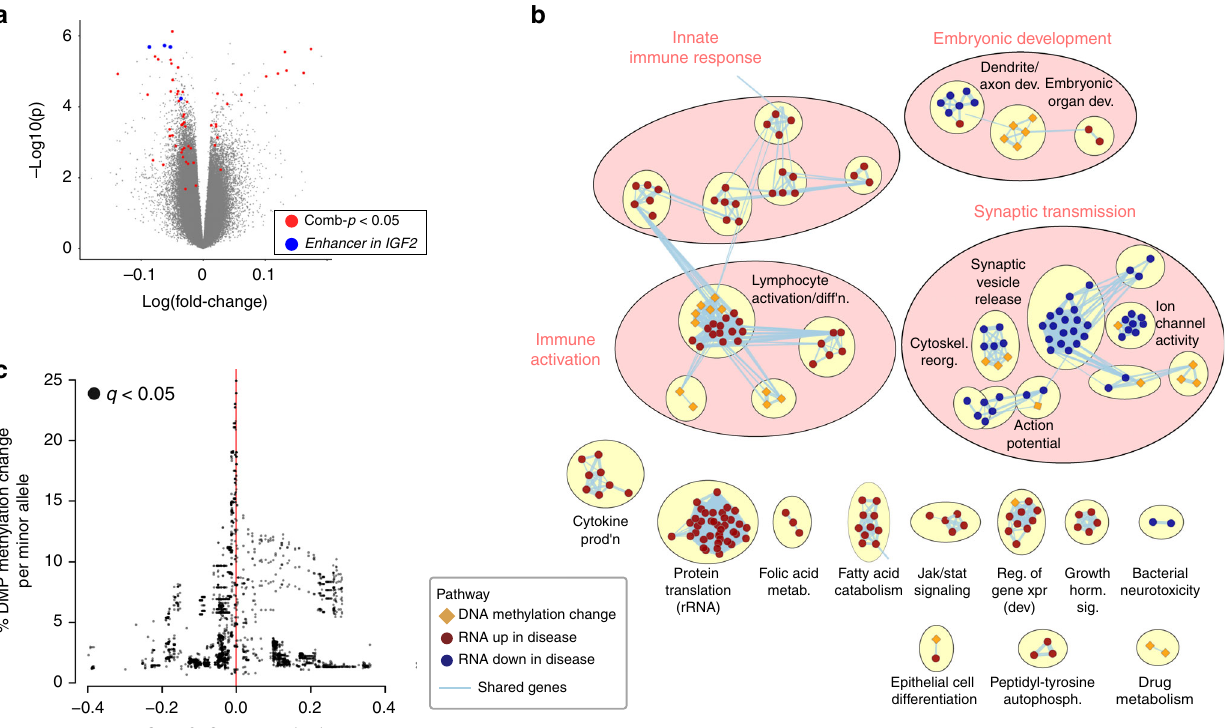
Fig. 1 Epigenetic and transcriptomic alterations in frontal cortex neurons in major psychosis. a Volcano plot showing DNA methylation differences in neurons of major psychosis patients ( n = 55 individuals) relative to controls ( n = 27 individuals). Disease-speci fi c DNA methylation changes were identi fi ed, after controlling for sex, age, post-mortem interval, and the fi rst two genetic principal components ( n = 406,332 probes). Red circles: Probes in regions with comb-p Š idák p < 0.05. Blue circles: Probes within the hypomethylated enhancer in IGF2 . b Pathways signi fi cantly affected by DNA methylation and/or transcriptomic changes in major psychosis. Nodes show pathways enriched with differentially methylated regions in psychosis (diamonds; q < 0.05; hypergeometric test; n = 48 pathways of 6858 tested) or enriched in differentially expressed genes (circles; q < 0.05; GSEA preranked; n = 5580 pathways tested), and edges indicate common genes. Node fi lls indicate up- (red nodes; n = 183 pathways) or down- (blue nodes; n = 64) regulation in disease; epigenetic pathways indicate change in disease (orange diamonds). Clusters of similar pathways are grouped in pink circles (Enrichment Map, AutoAnnotate). Clusters with fewer than three nodes are not shown, unless these have both epigenetic and transcriptomic pathways. c Signi fi cant genetic-epigenetic cis interactions of differentially-methylated regions. The y-axis shows percent change in DNA methylation with increasing number of minor alleles, ( q < 0.05; linear regression; n = 4762 interactions, 2212 SNPs with CpGs located in 18 differentially methylated